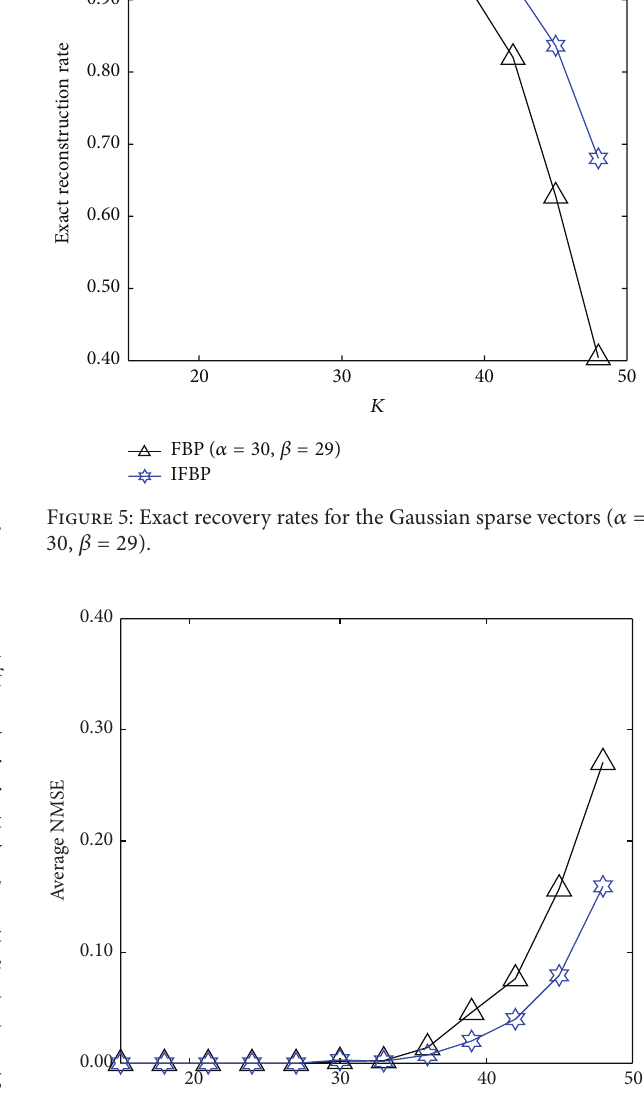
number of smaller and simpler problems. In order to adapt to the small size, we take the observation size 𝑀 = 32 , which is the same for each block. The observation matrix Φ is randomly drawn from the Gaussian distribution with mean 0 and standard deviation 1/𝑁 . Then, we normalize each column norm to unity. The parameters are selected as = 16 and 𝜀 = 10 −6 . We take FBP ( 𝛼 = 10 , 𝛽 = 9 ) 𝐾 max as the parent algorithm of IFBP in this example. Meanwhile, this example selects 𝐼 = 4 and 𝑆 = 0.5𝐼 for